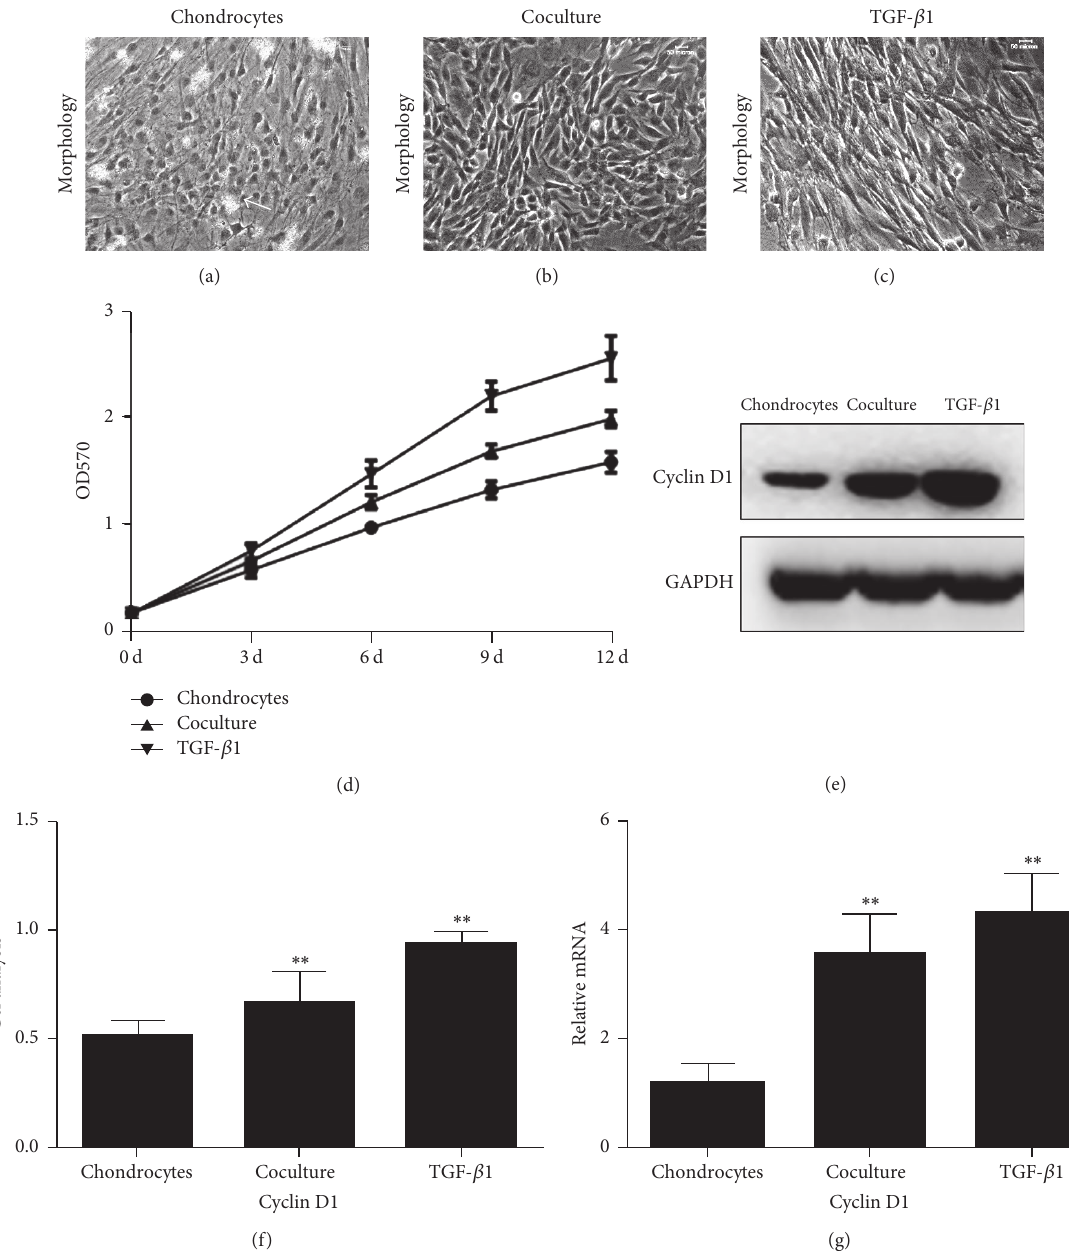
Figure 4: Proliferation of chondrocytes cultured with three different conditions for 5 days. Morphology of chondrocytes culture with a control medium (a), ADSCs coculture condition (b) and TGF- 𝛽 1-containing medium (c). Growth curves of chondrocytes cultured in three differentconditionsareshown((d),(e)).Chondrocytes:chondrocyteswereculturedinnormalculturemedium.Coculture:chondrocyteswere cocultured with ADSCs. TGF- 𝛽 1: chondrocytes were cultured with TGF- 𝛽 1-containing medium. All were determined by MTT assay. Cyclin D1 protein expression in chondrocytes cultured in three different conditions for 5 days as determined by western blot (f). Gene expression of Cyclin D1 in chondrocytes cultured in three different conditions for 5 days as determined by real-time PCR. Data are shown as mean ± SEM. ∗∗ 𝑝 < 0.01 versus control group